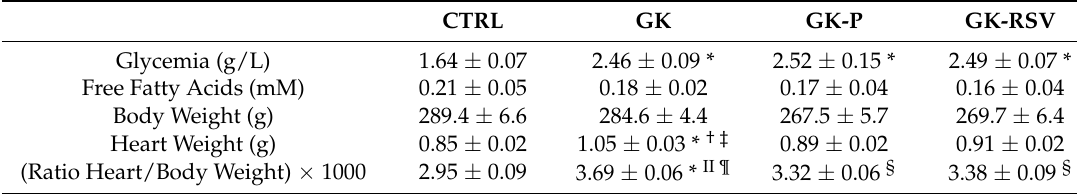
Table 1. Physiological parameters of experimental